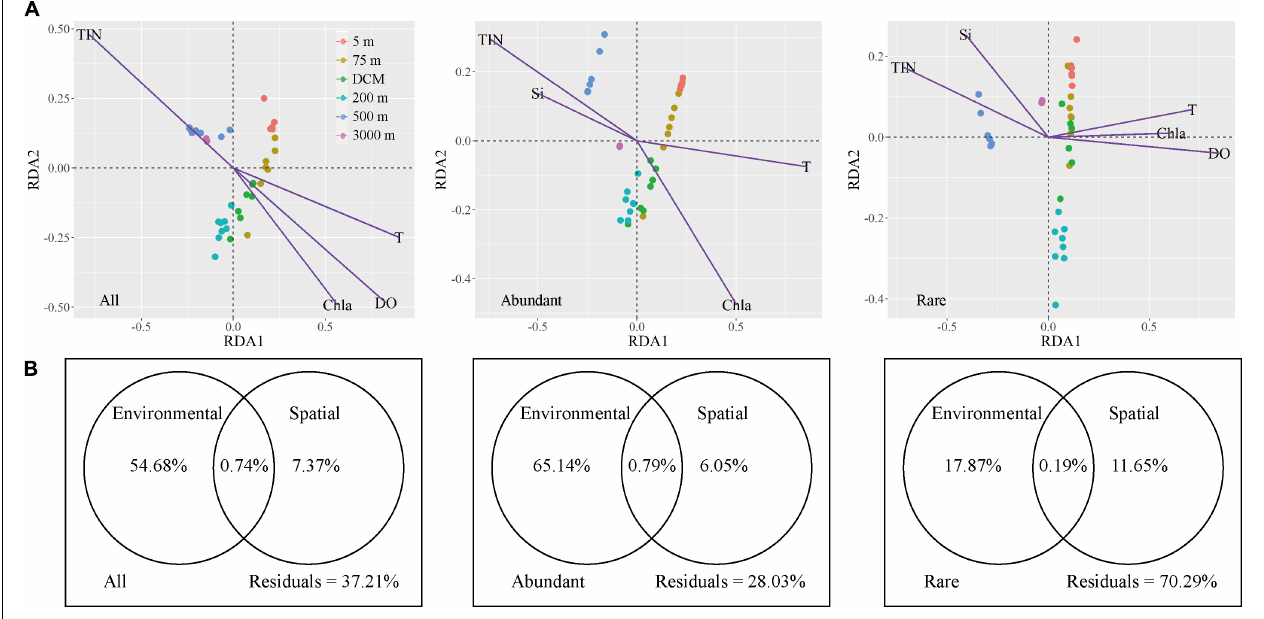
FIGURE 6 | The variation in microbial community explained by spatial and environmental variables, respectively. (A) RDA ordinations showing the microbial taxonomic composition in relation to significant ( P < 0.05) environmental variable. TIN, total inorganic nitrogen, T, temperature, Chla, chlorophyll a , Si, silicate, DO, dissolved oxygen. (B) Variation partitioning analysis of the microbial taxonomic composition between spatial and environmental